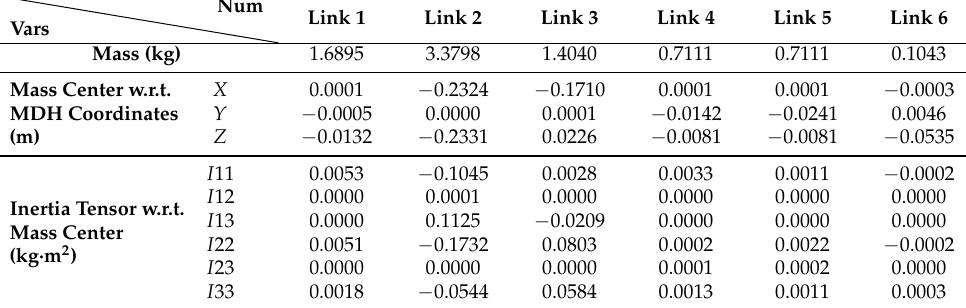
Table A3. Kinetic parameters.